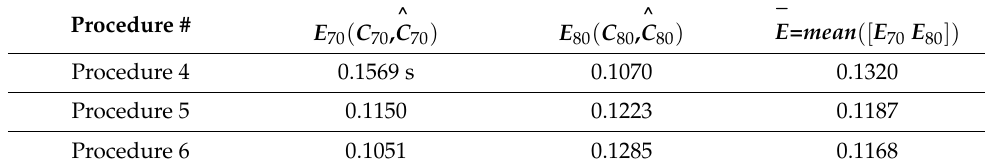
and ˆ C sp (procedures 4, 5, and 1 1